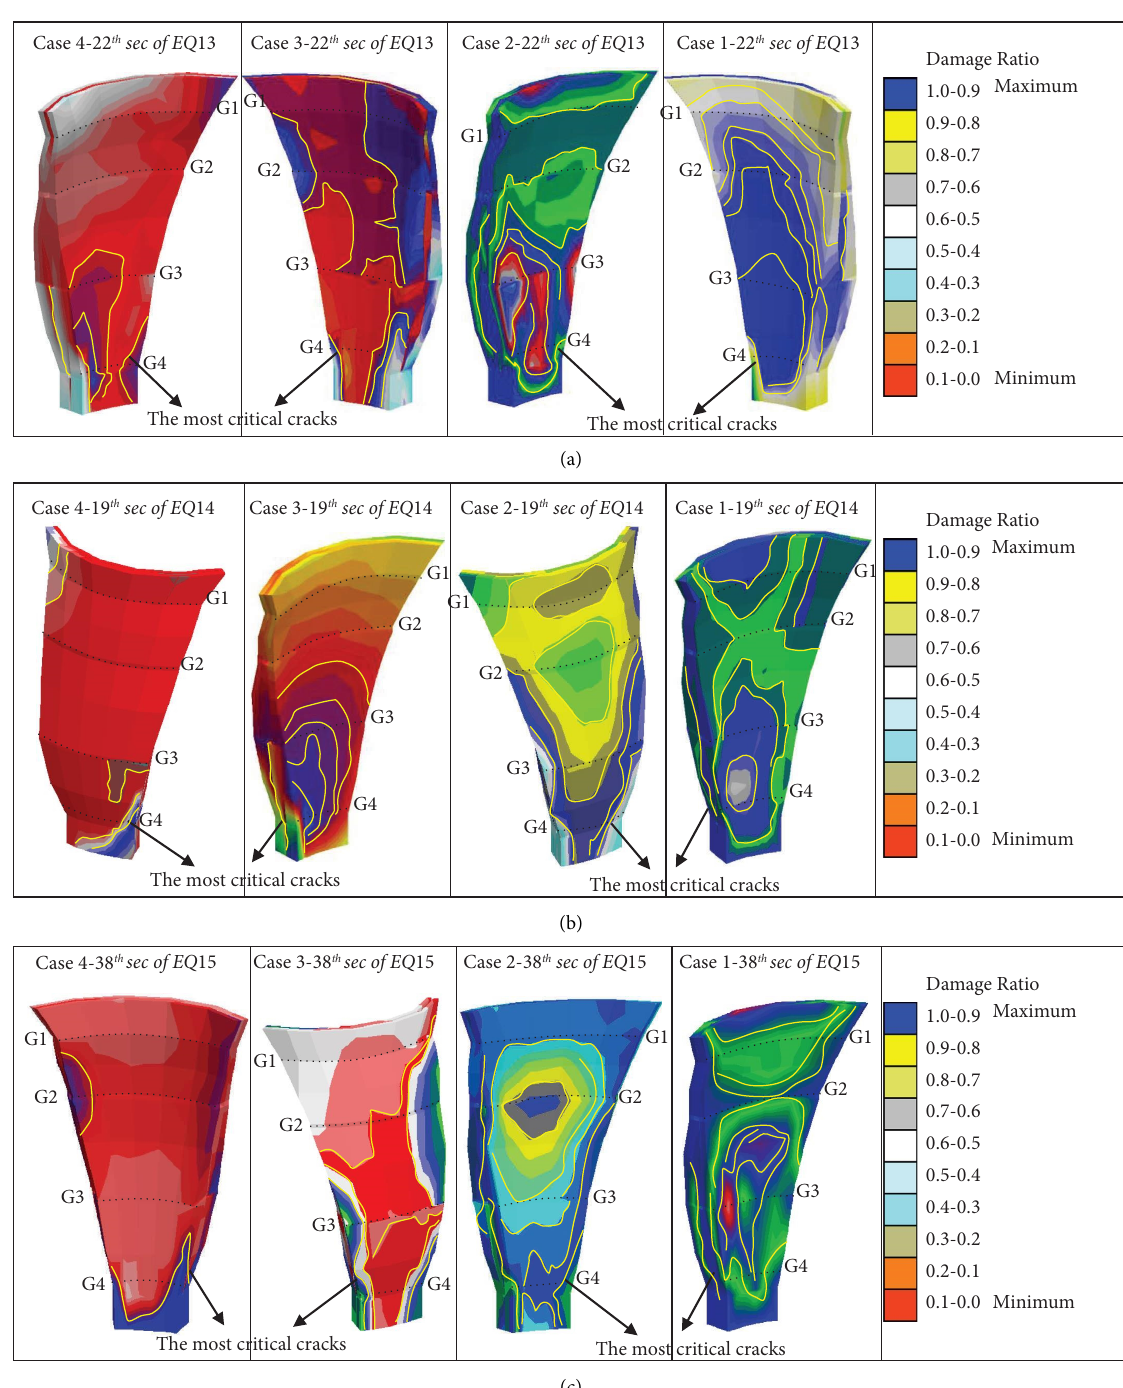
Figure 16: Earthquake crack performance of Ermenek arch dam for (a) EQ13 earthquake, (b) EQ14 earthquake, and (c) EQ15